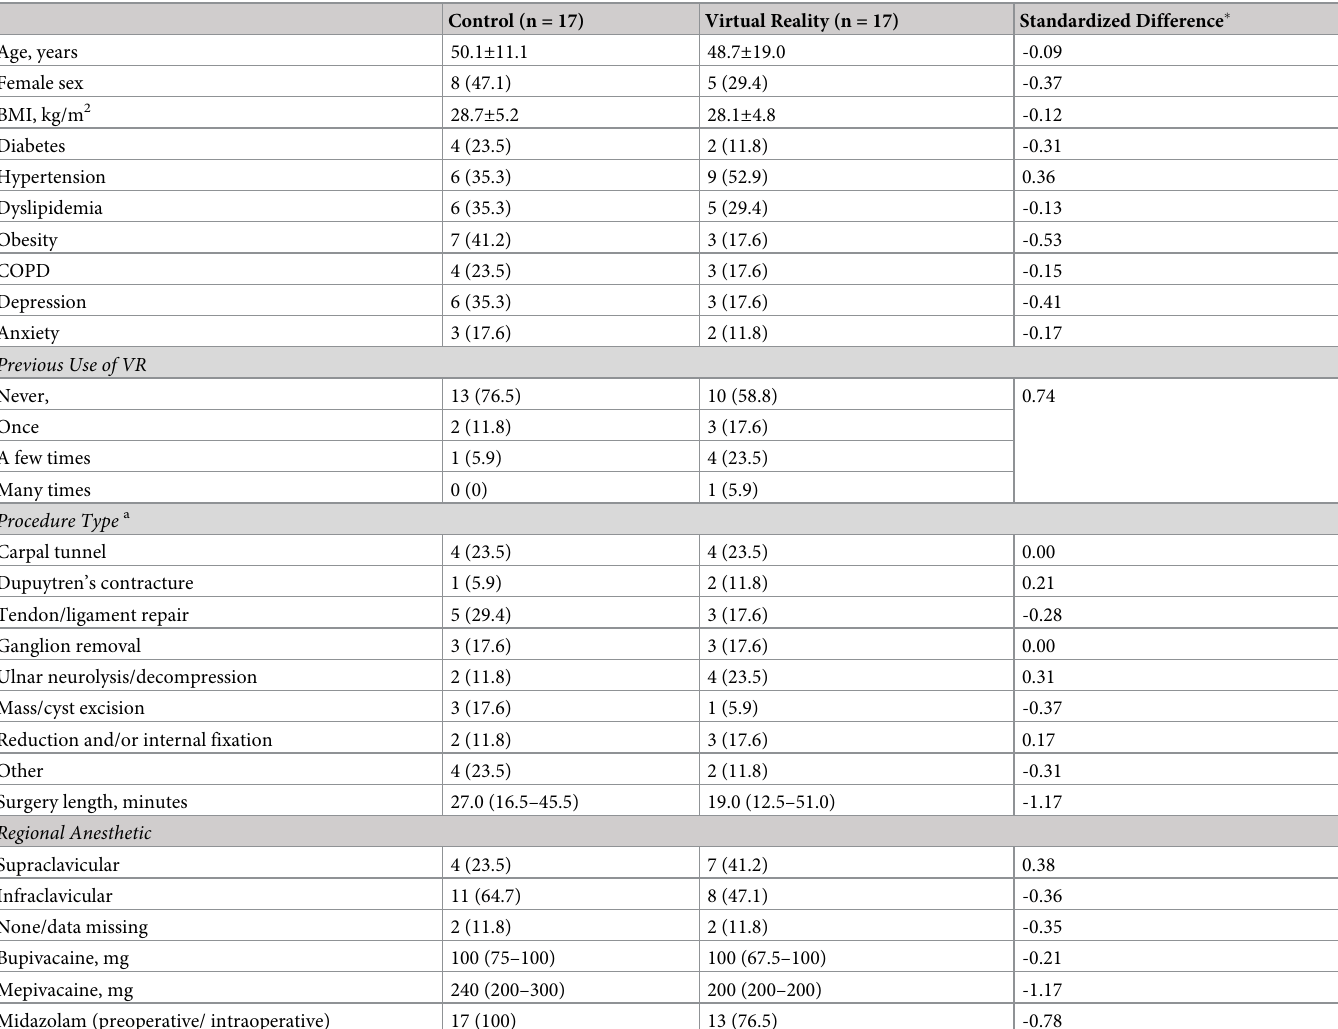
Table 1. Preoperative